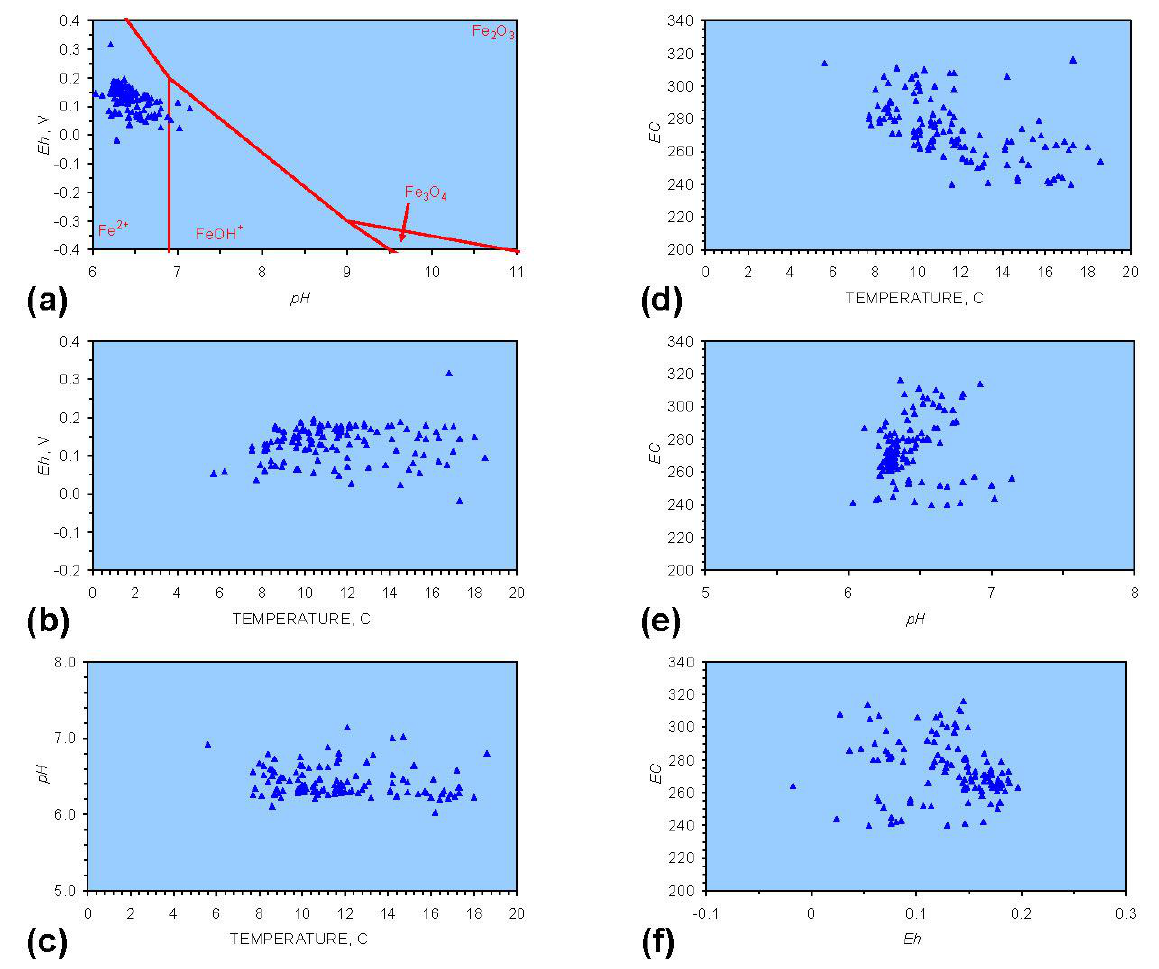
Figure 1. Eh-pH relationship for feed water. (a) natural variation in groundwater mound (March–July 2010). Redox fences for Fe from [1]; (b) Eh vs. Temperature; (c) pH vs. Temperature; (d) EC (μS cm −1 ) vs. temperature; (e). EC (μS cm −1 ) vs. pH; (f) EC (μS cm −1 ) vs. Eh. Temperatures are the sampled temperature of water abstracted from the groundwater